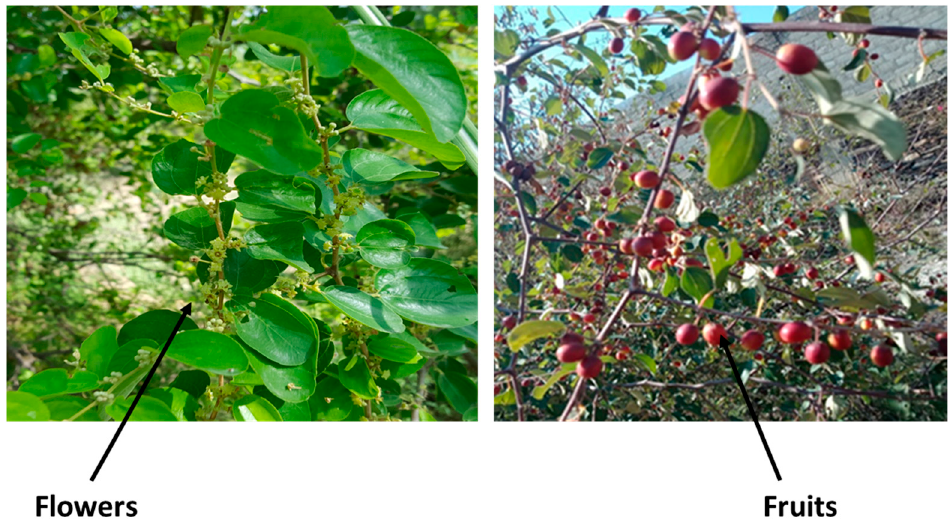
Figure 1. The flowers and fruits of red color cultivars of Z. mauritiana . This picture of Z. mauritiana with red color fruits and flowers was originally taken from a Z. mauritiana tree growing in Gora Gat, Dir Lower, KP, Pakistan.